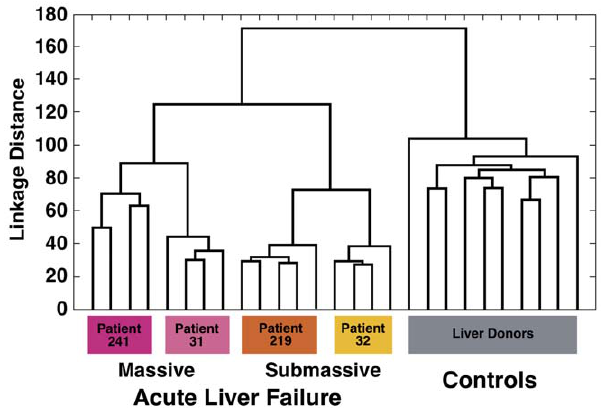
Figure 4. Hierarchical clustering. Hierarchical cluster analysis of 17 liver specimens from 4 patients with acute liver failure and 10 specimens from individual liver donors using all 11,597 transcripts that passed the filtering criteria. All specimens were grouped into 3 main clusters, which correspond to the 3 liver conditions (ALF with MHN, ALF with SHN and liver donors). The unsupervised nature of the analysis and the 100% correct classification of samples suggest a high specificity and sensitivity of gene expression differences between ALF and normal livers.